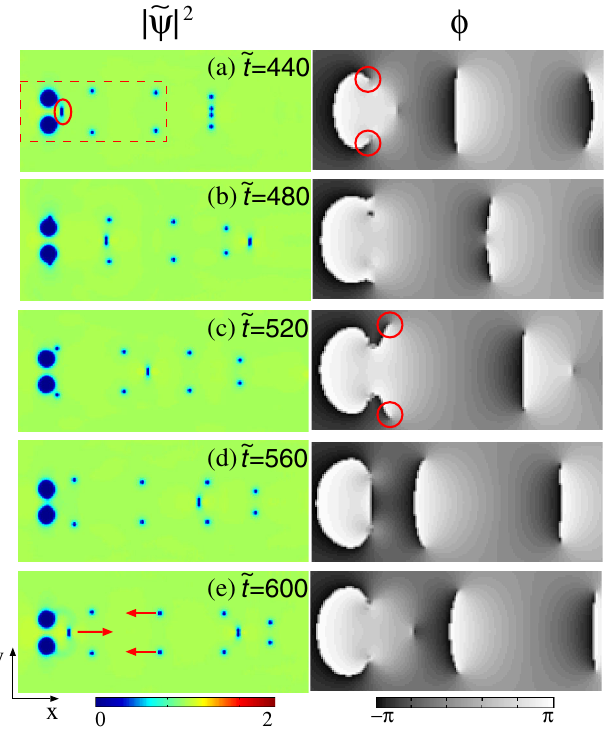
FIG. 4. Dynamics of the density j ~ c j 2 ¼ j c j 2 =n and phase 0 Þ ¼ = ð gn (cid:7) ¼ arg c profiles for two Gaussian potentials with V 0 0 ¼ 0 : 32 , and D=(cid:2) ¼ 14 in the frame comoving 5 , d=(cid:2) ¼ 3 , v=v s with the potential. The phase profiles magnify the region in the dashed square. The circle in the left panel of (a) indicates a vortex dipole released from between the potentials, and those in the right panel indicate its counterpart remaining in the poten- tials. The circles in (c) indicate the counterpart released from the potentials. The arrows in (e) indicate the directions in which the vortices propagate. The field of view of the density profiles is 160 (cid:2) (cid:5) 67 (cid:2) . (See also Supplemental Material